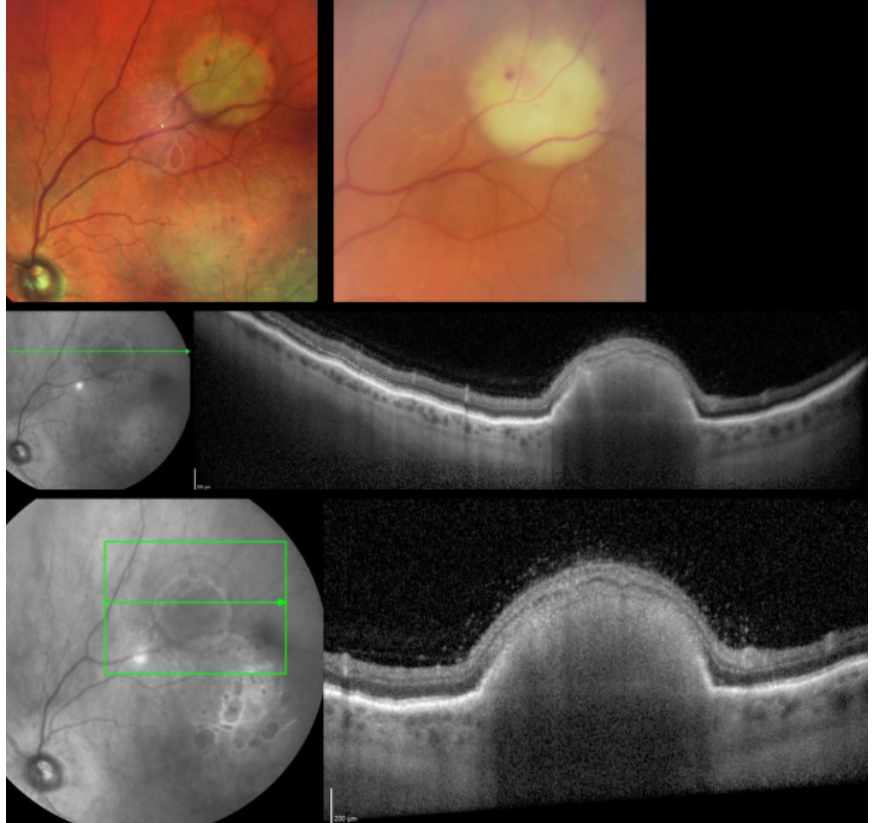
Figure 2: Fundal photographs and OCT scan images showing left subretinal abscesses